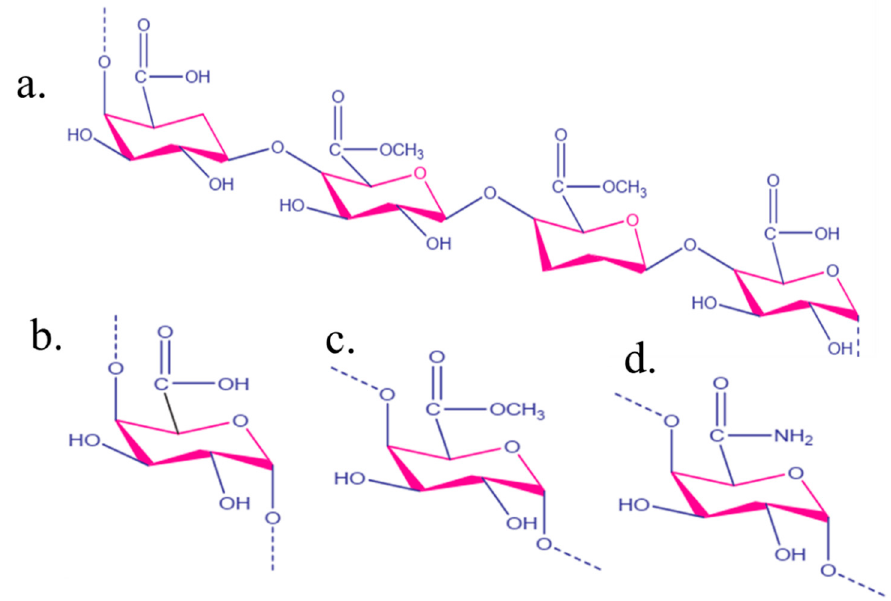
Figure 1. ( a ) The frequent unit of chemical moieties in the Pec chemical structure, ( b ) carboxylic, ( c ) ester, and ( d ) amide groups. Reproduced with permission [46].